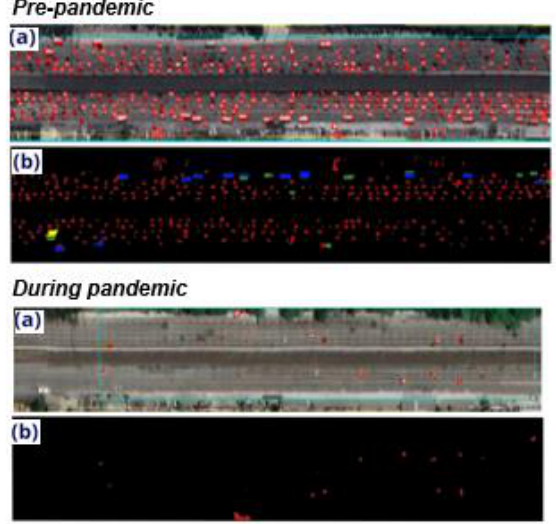
Figure 6. Vehicles in Araneta Center delineated in (a) Google Earth image and (b) segmentation output